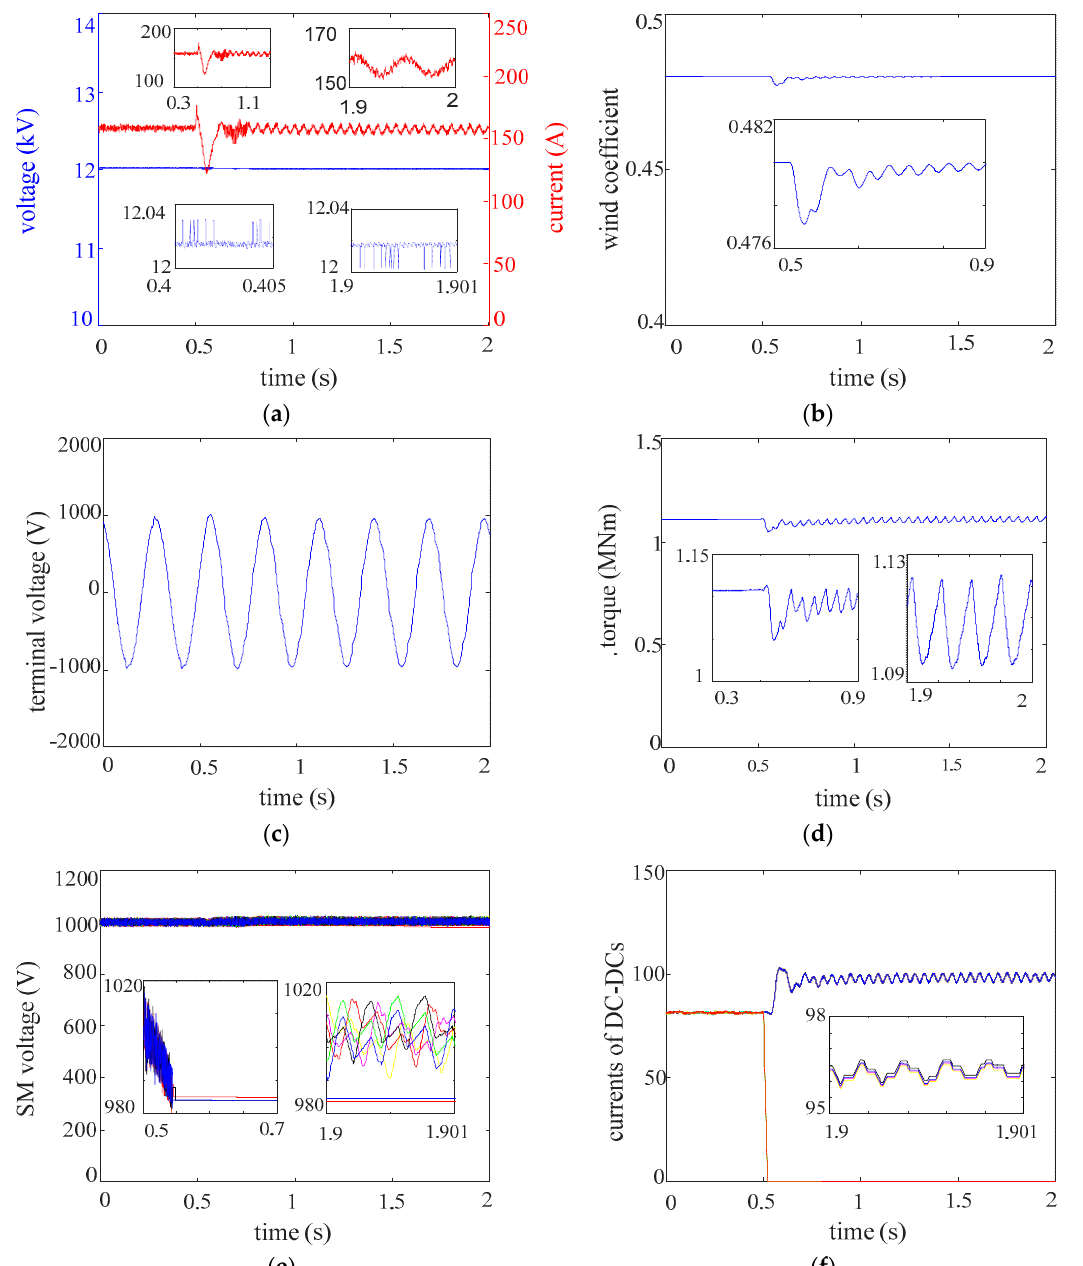
Figure 7. Simulation results when one set of three-phase winding was open circuited: ( a ) DC transmission voltage and current; ( b ) Wind power coefficient; ( c ) Terminal voltage of PMSG; ( d ) Electromagnetic torque; ( e ) SM capacitor voltages; ( f ) Currents of DC–DC converters.